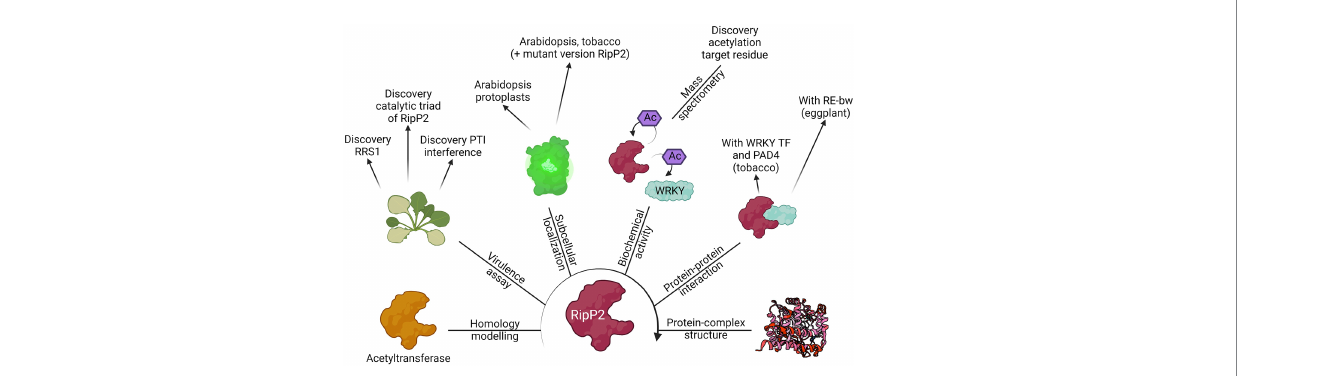
FIGURE 4 The route for the functional characterization of RipP2. Different laboratories have contributed to the elucidation of the putative function of the T3E RipP2, formally known as PopP2, by using the different methods discussed in this review. Starting from its homology with other known acetyltransferases, the biochemical activity of the T3E (acetylation of WRKY transcription factors, including RRS1) was found as well as the catalytic residues responsible for this function. Eventually, the apo crystal structure of RipP2 or RipP2 in complex with IP 6 , acetyl-CoA, and the WRKY domain from RRS1-R was determined. This figure provides an overview of the results found by Deslandes et al. (2003), Tasset et al. (2010), Le Roux et al. (2015), Xiou et al. (2015), Zhang et al. (2017), Xia et al. (2021), and Huh